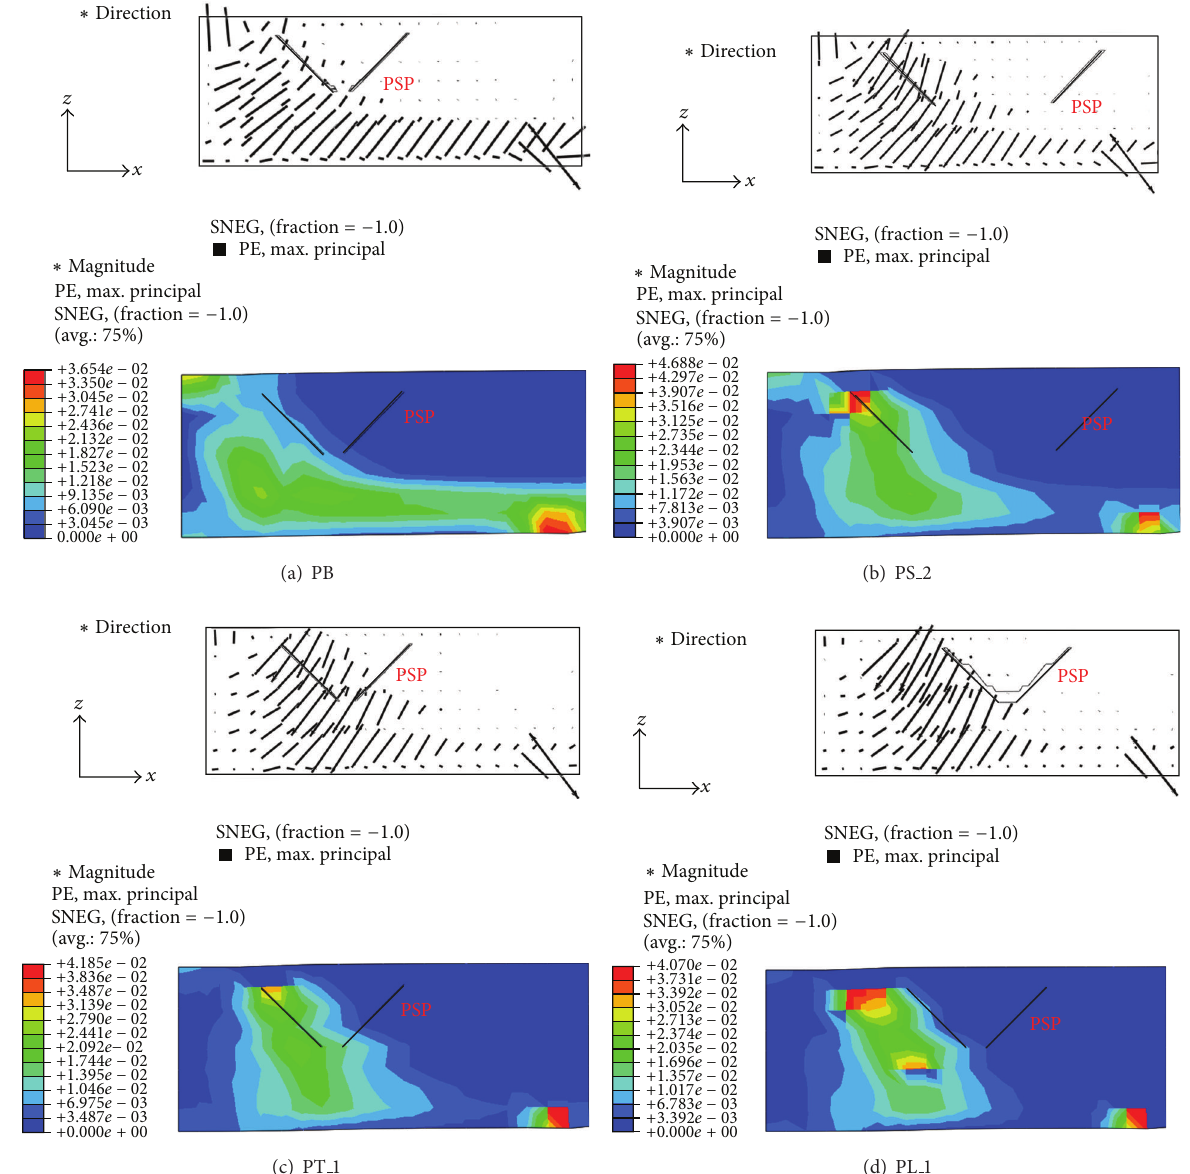
Figure 18: Cracking patterns of analysis models: (a) PB; (b) PS 2; (c) PT 1; and (d) PL